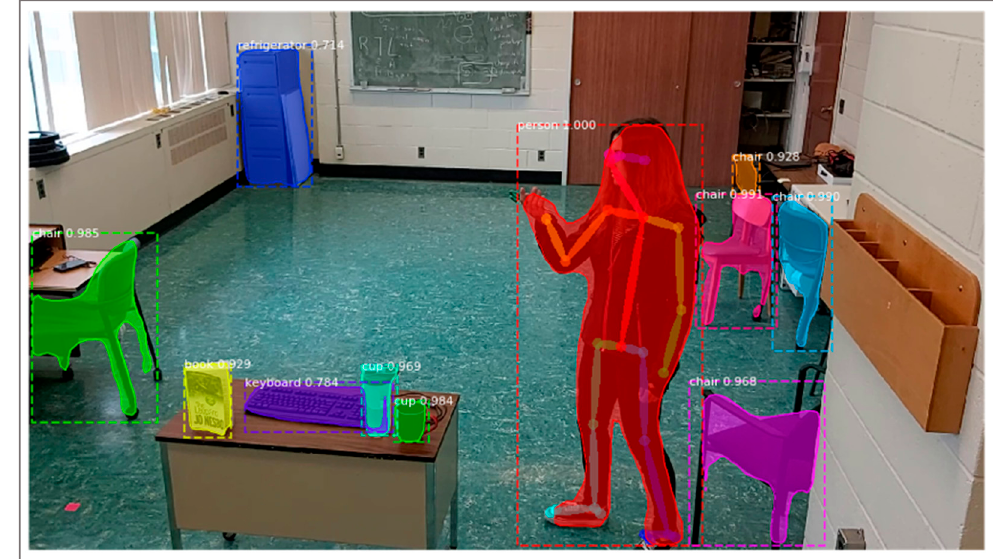
Figure 2. Example of the processing of pose detection presented to the focus group participants.